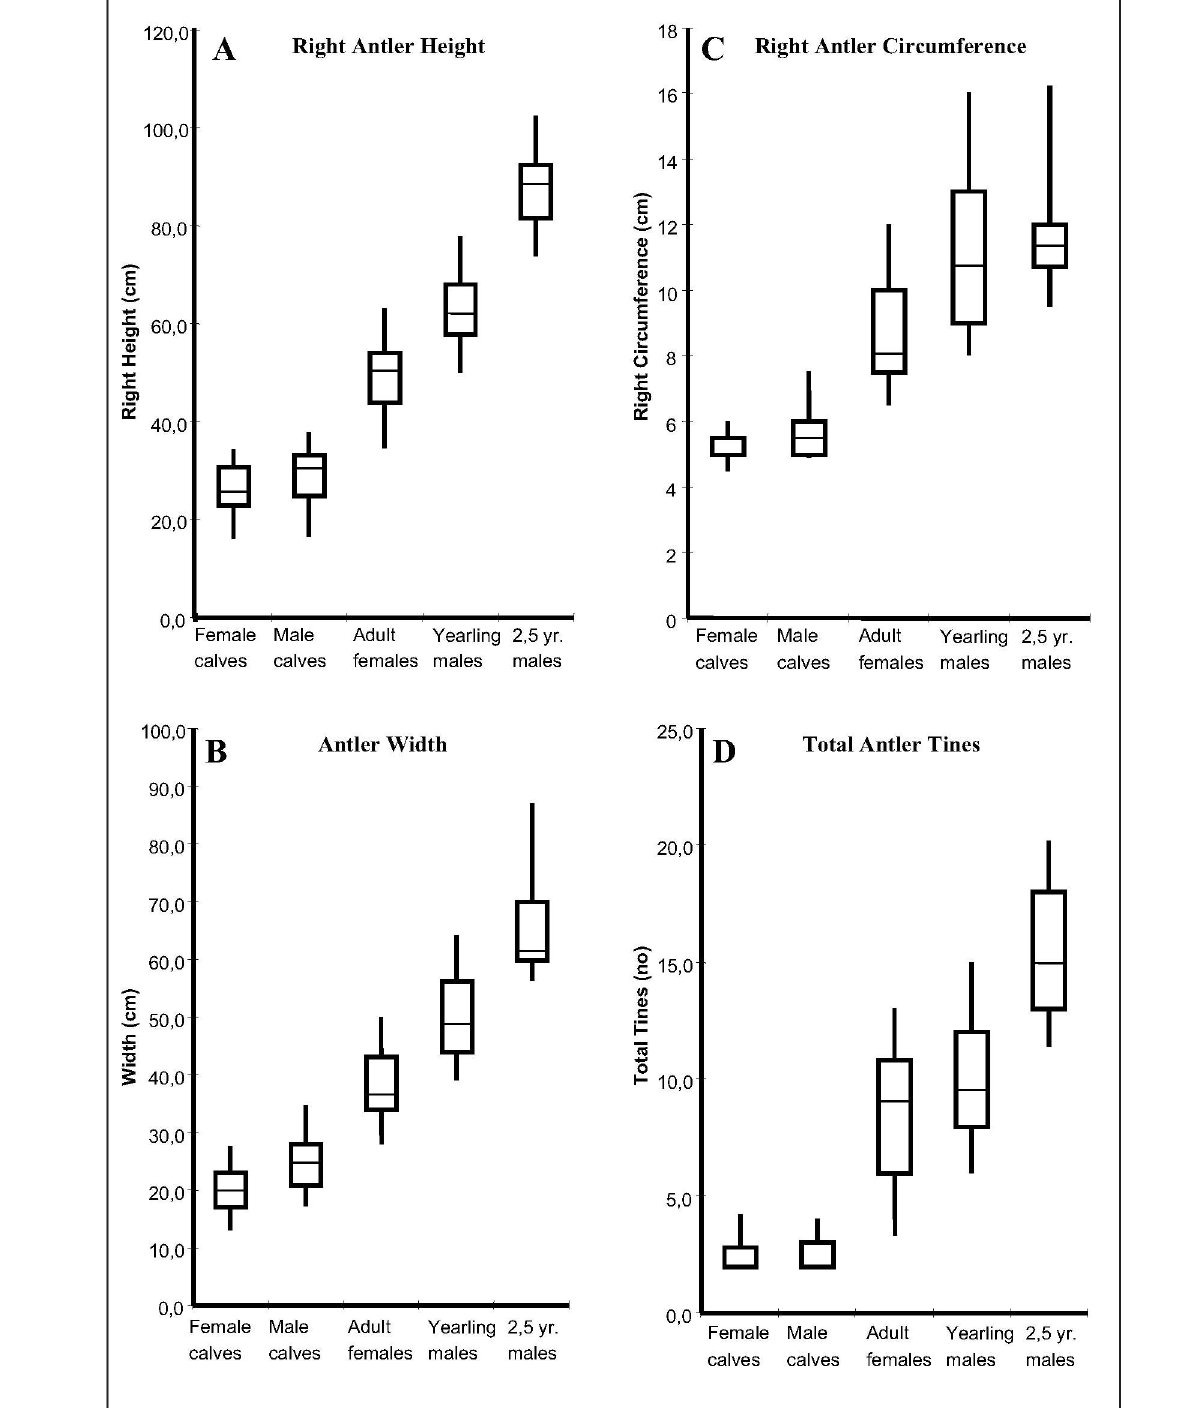
Fig. 2. Differences in antler characteristics among different semi-domestic reindeer groups. The boxes represent 50% of the data and the lines 90% of the data. From bottom up are the 5, 25, 50 (line in the box), 75 and 95% percentiles (Table